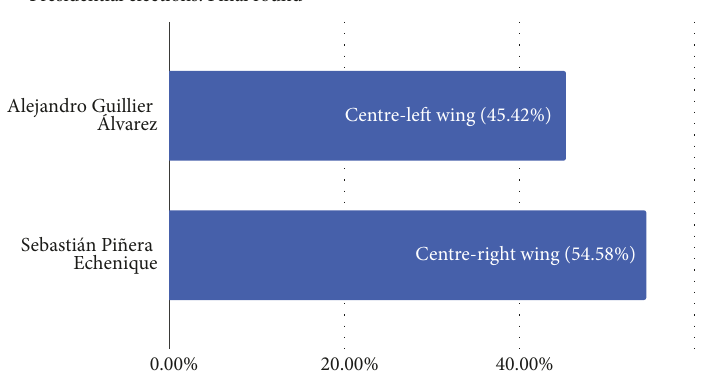
Figure 2: Second round results of the 2017 Chilean presidential